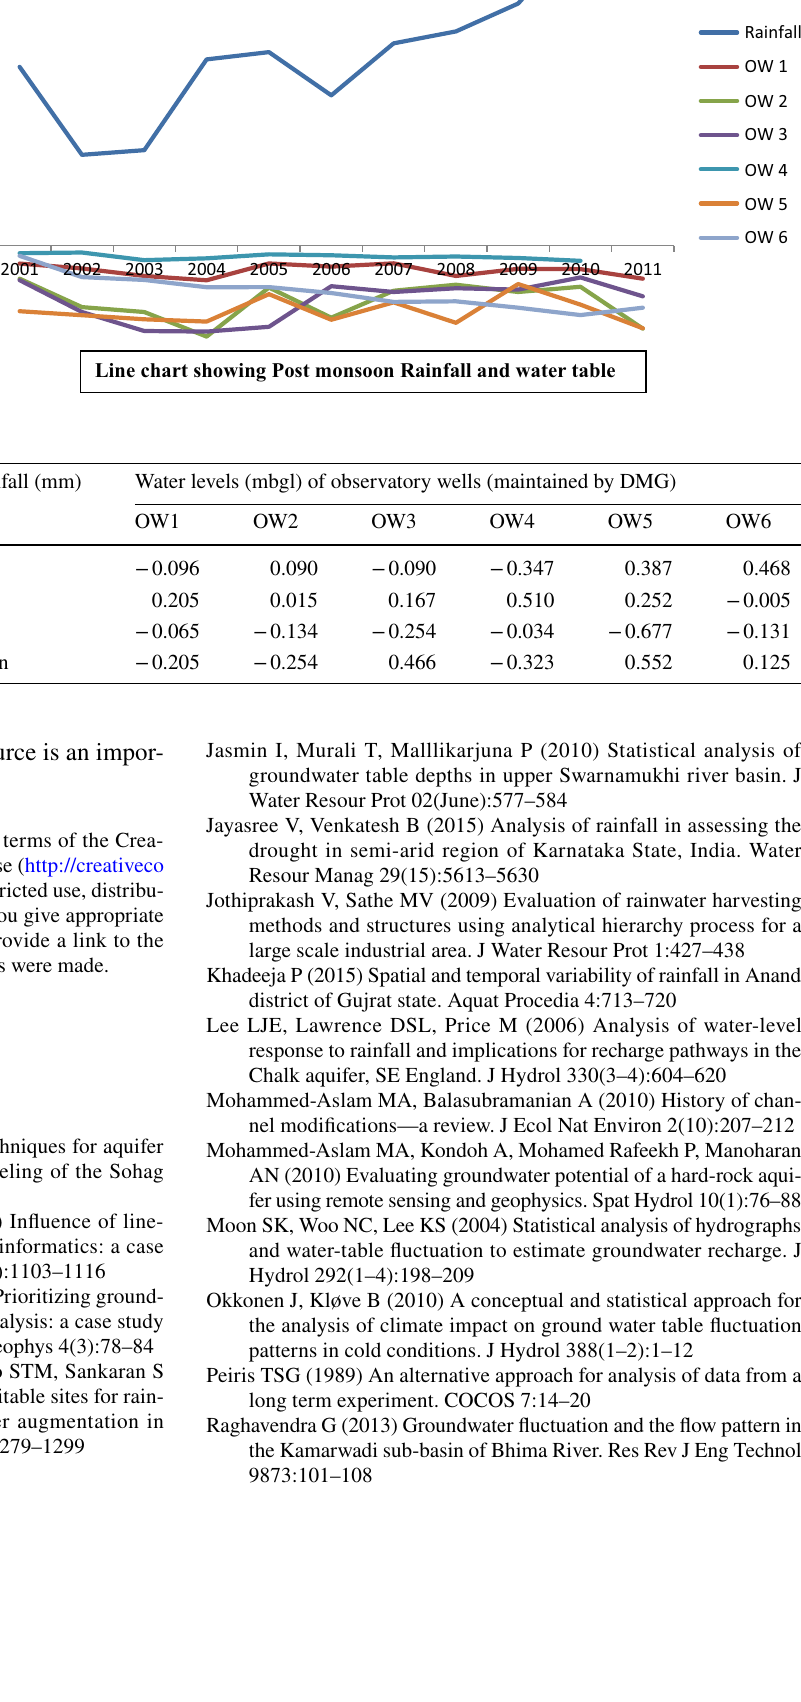
Fig. 9 Line chart represent- ing post-monsoon rainfall and water-table trends